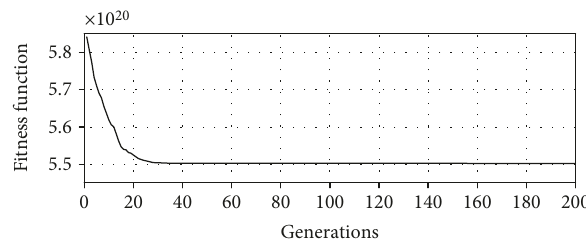
Figure 22: Evolution of the fi tness function of strategy 7 through